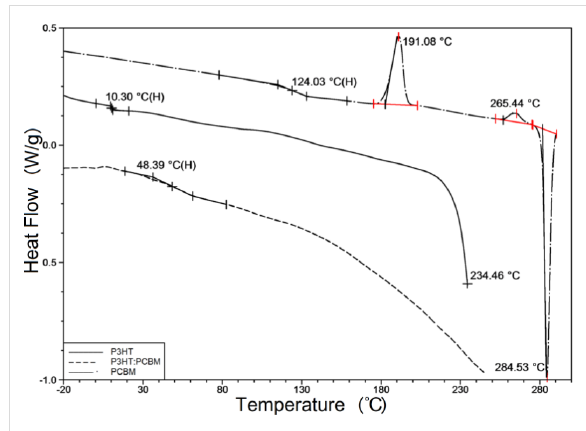
Figure 5: DSC plots with a heating rate of 20 °C/min for P3HT, PCBM and P3HT:PCBM (1:1), recorded with powder materials (P3HT and PCBM) and with the P3HT:PCBM (1:1) film scrapped off a glass sub- strate.